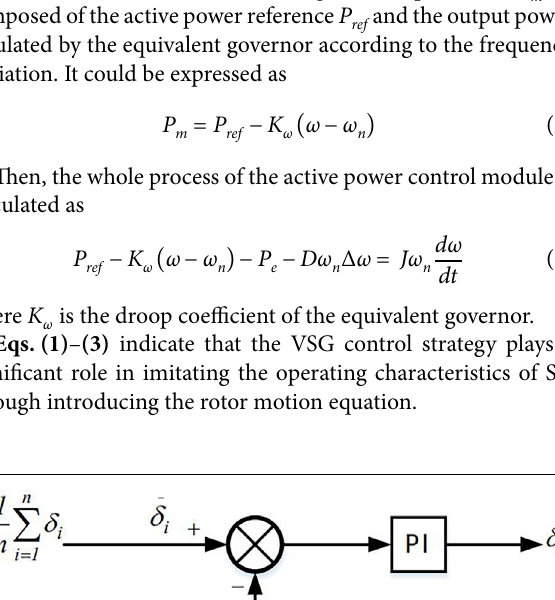
is the frequency deviation. In both grid-connected state and the PCC, and it is directly collected by the phase-locked loop.